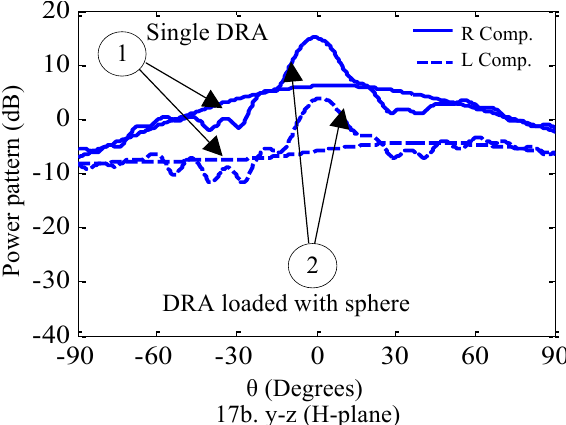
Figure 15: Reflection coefficient versus frequency for DRA loaded with dielectric sphere compared to single DRA.